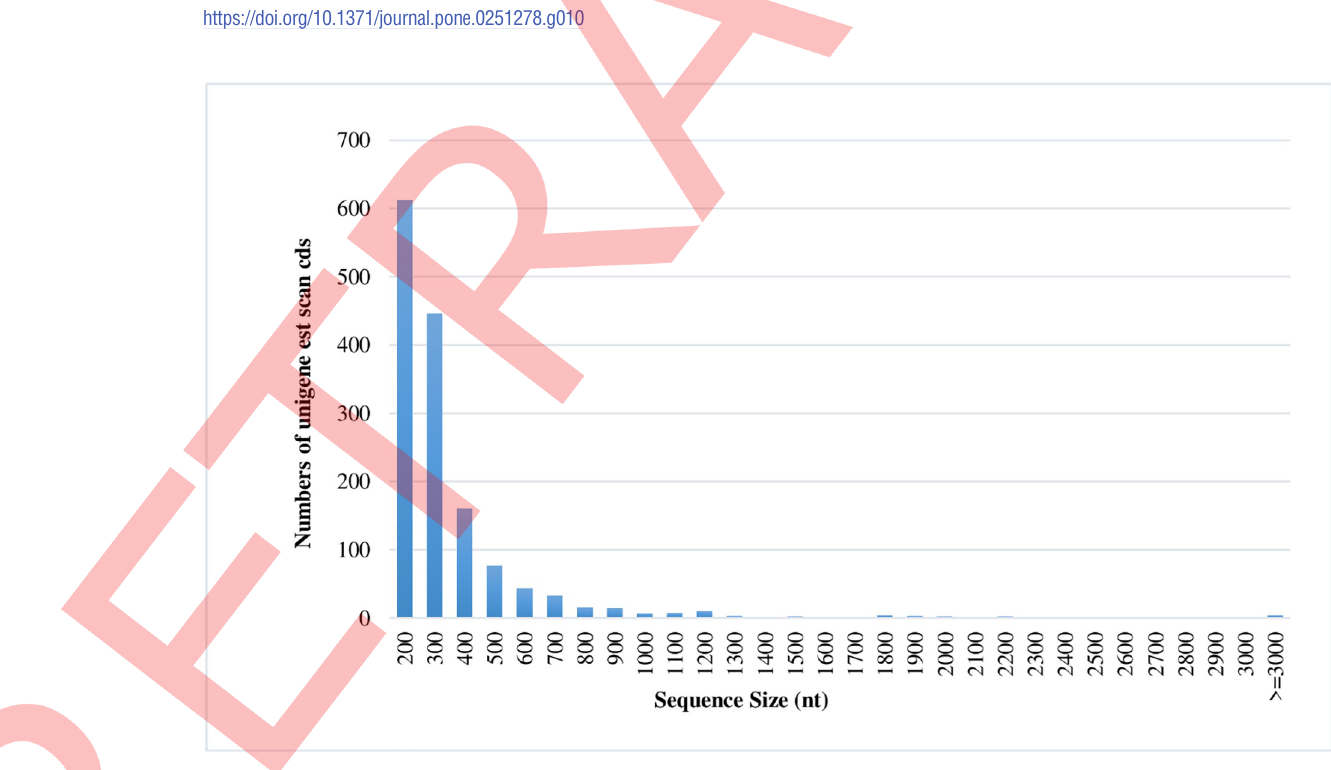
Fig 11. Length distribution of EST scanned CDS from transcriptome data of Rhynchophorus ferrugineus fat body tissues. Nucleotide sequence size (nt) and numbers of unigene EST scans are indicated on the X- and Y-axes, respectively.